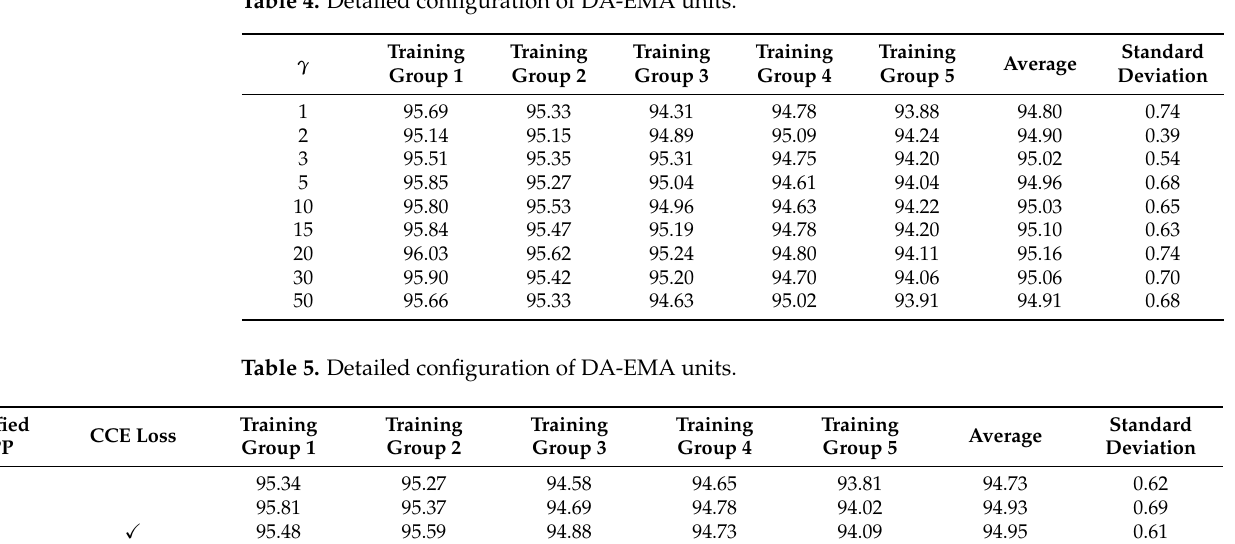
Table 4. Detailed configuration of DA-EMA units.